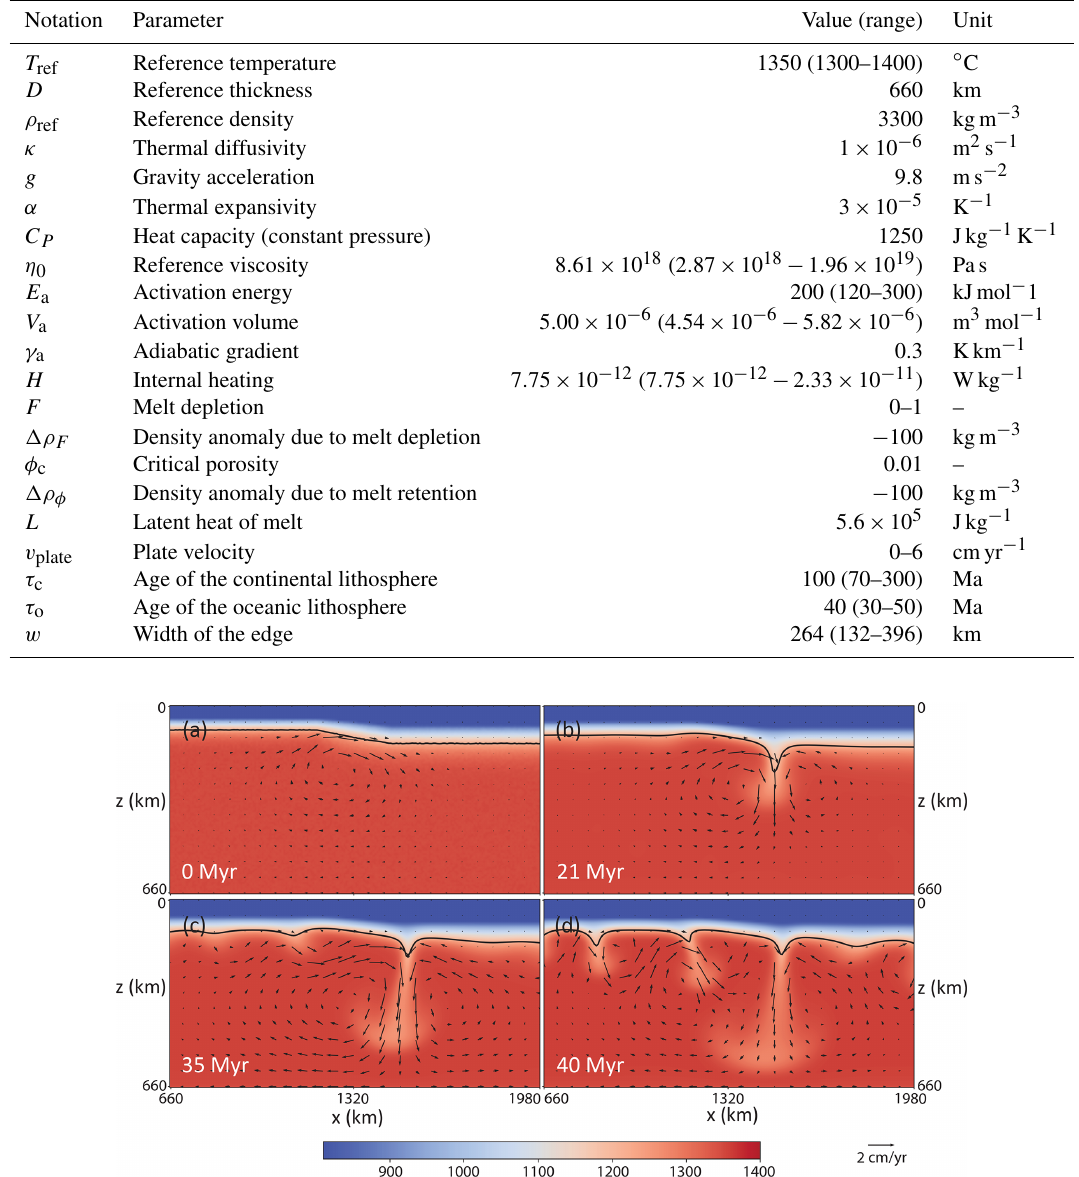
Table 1. Relevant reference parameters for the models described in this chapter. Values in parentheses represent the explored parameter space, with the exception of V a (see Sect. 2 for explanation).